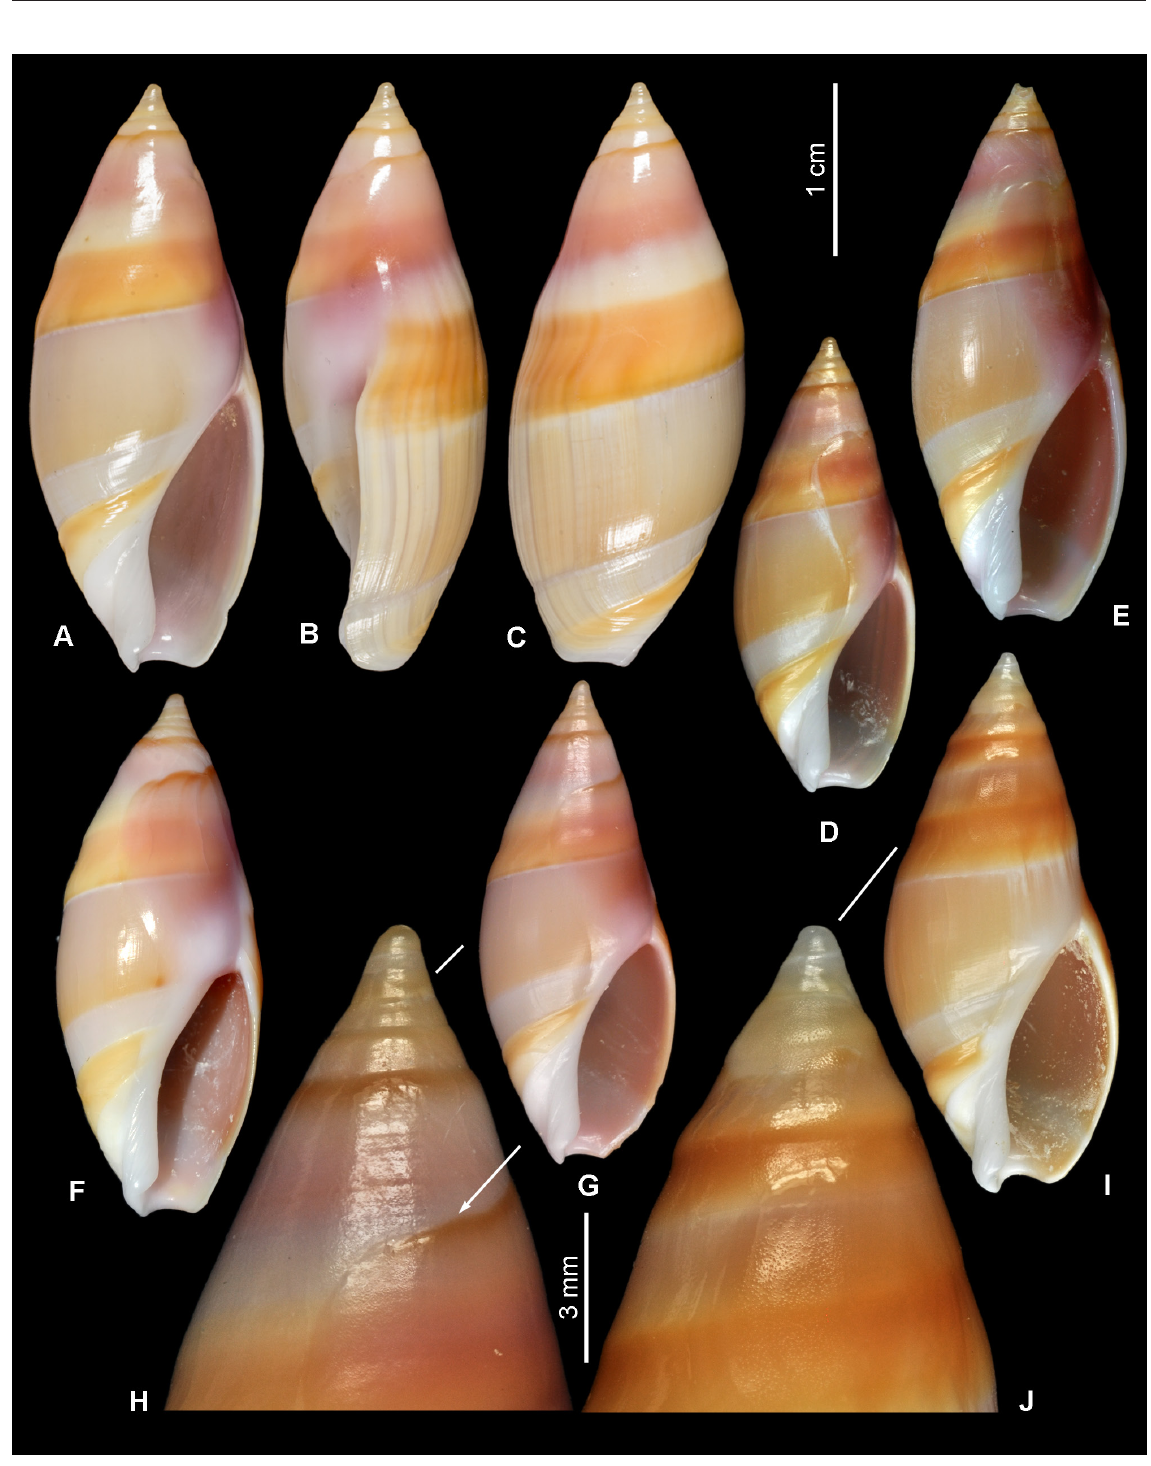
Fig. 8. A–H . Amalda aureomarginata Kilburn & Bouchet, 1988, southern New Caledonia. A–C . Holotype, MNHN IM-2000-1345, SL 34.1 mm. D . MNHN IM-2007-43644, SL 26.6 mm. E . MNHN IM-2007- 43655, SL 31.5 mm. F . MNHN IM-2007-43551, SL 30.5 mm. G–H . MNHN IM-2007-43654, SL 28.2 mm. I–J . A. hilgendorfi (von Martens, 1897), MNHN IM-2009-11968, northern New Caledonia, SL 31.6 mm. Shells at the same scale; H, J = enlarged upper part of the shell. Arrow on H points at dark brown line, bordering secondary